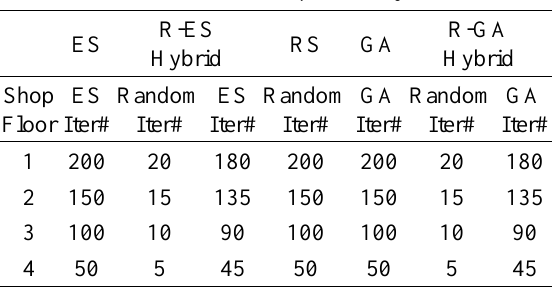
Table 4. Iteration numbers for pure and hybrid